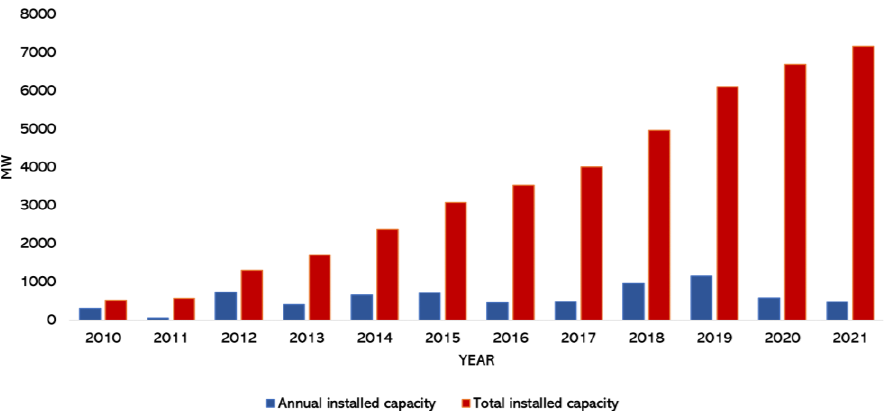
Figure 2. Evolution of installed wind capacity in Mexico. Source: [10].